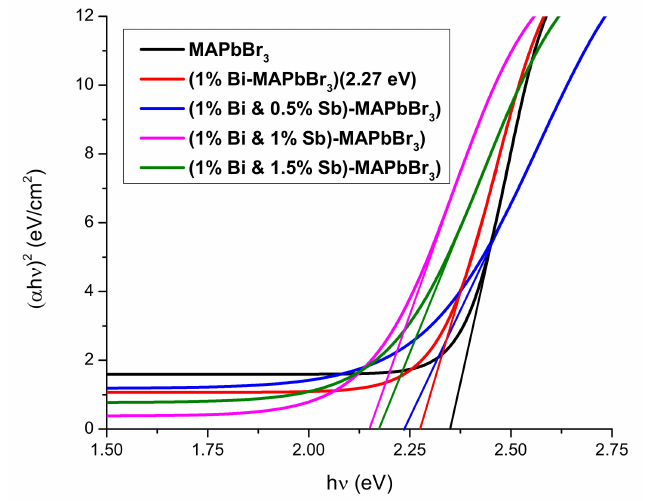
Figure 5. E g of pure MAPbBr 3 and 1% Bi and (0%, 0.5%, 1%, 1.5%) Sb co-doped MAPbBr 3